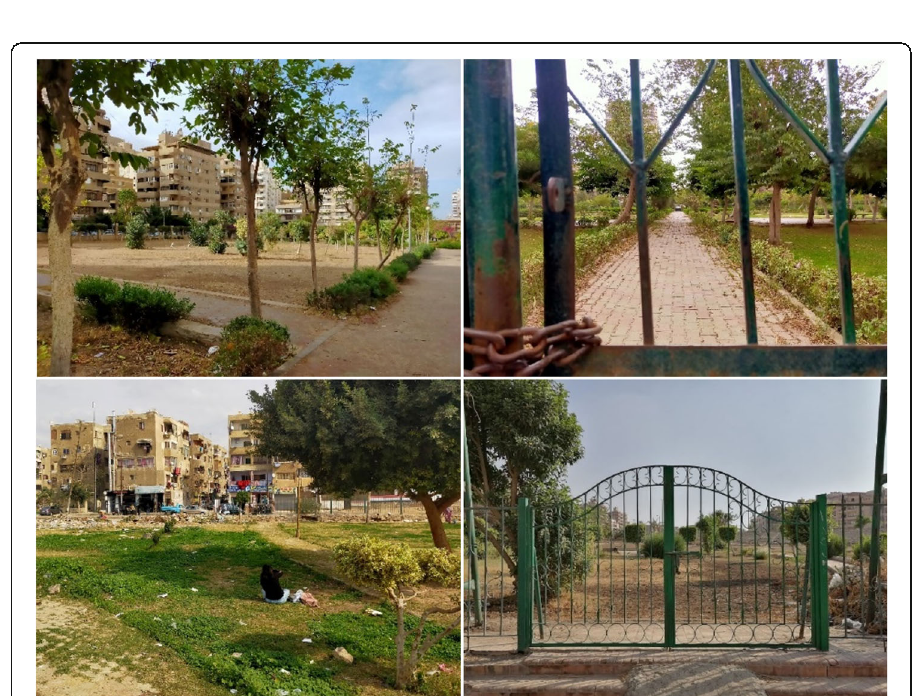
Fig. 12 Examples of closed/deteriorated amenity green spaces, Nasr City and